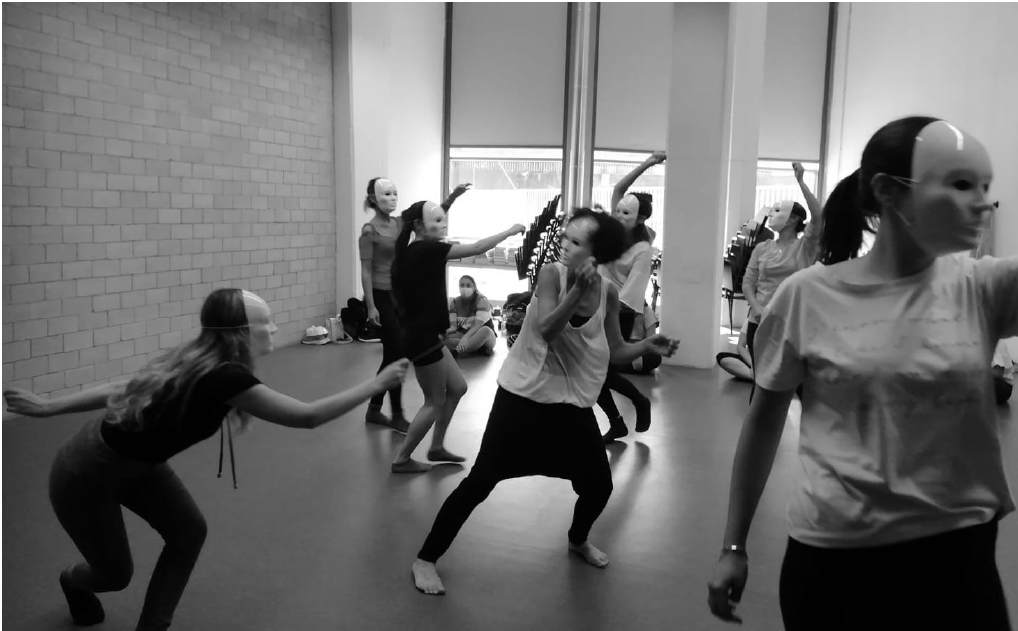
Figure 1. Participants to the DMT workshop wearing neutral masks . The games and their respective learning objectives are presented in Table 1. Safety protocols were respected at all times: participants maintained silence during the games and kept at least 1 m of distance between themselves and used personal protective equip ‐ ment. Neutral masks were disinfected after each 6 h session. Table 1. Organisation of the Relational Expressive Dance Movement Therapy (DMT ‐ ER) third ‐ year workshop, description of the games and their objectives. Name